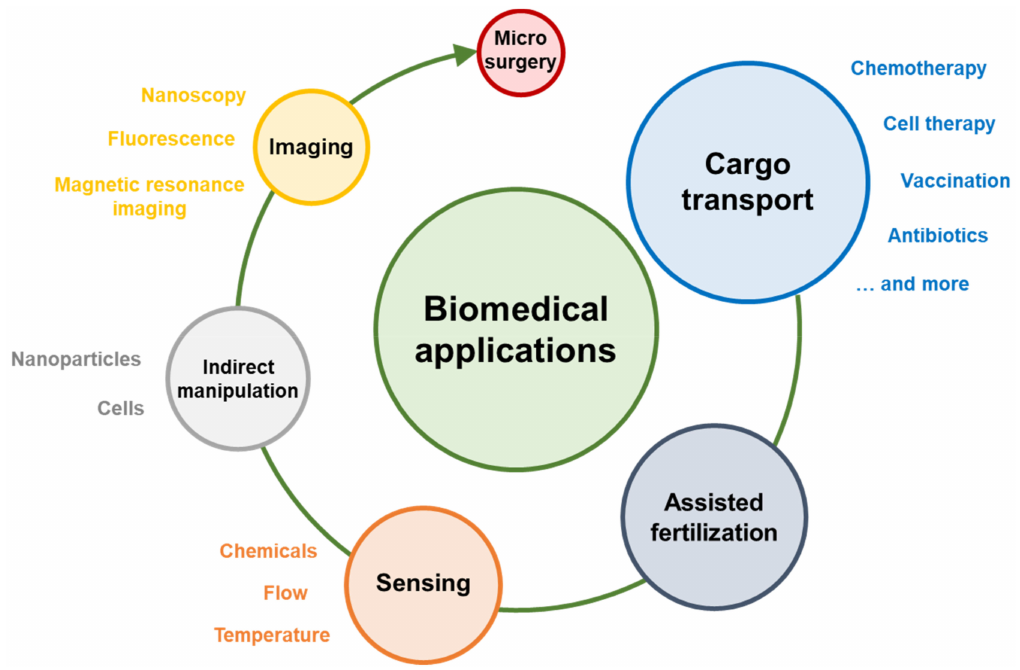
Figure 2. Schematic representation of the biomedical applications of microswimmers. The figure also serves as a guide for the structure of this